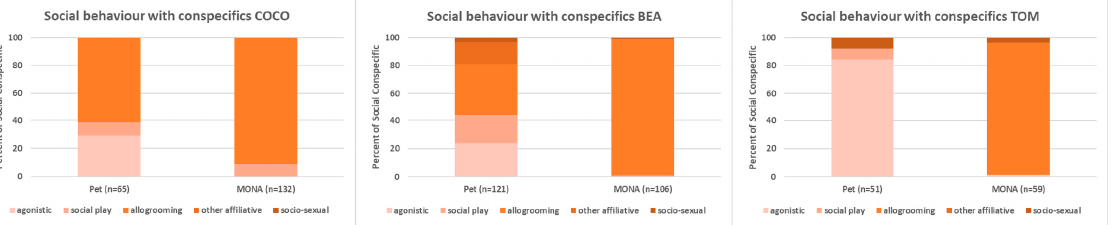
Figure 5. Comparison of the proportions of time spent on the different subcategories of social behaviour with conspecifics while housed as pets, and after living at MONA for about 10 years for Coco ( left ), Bea ( middle ) and Tom ( right ).